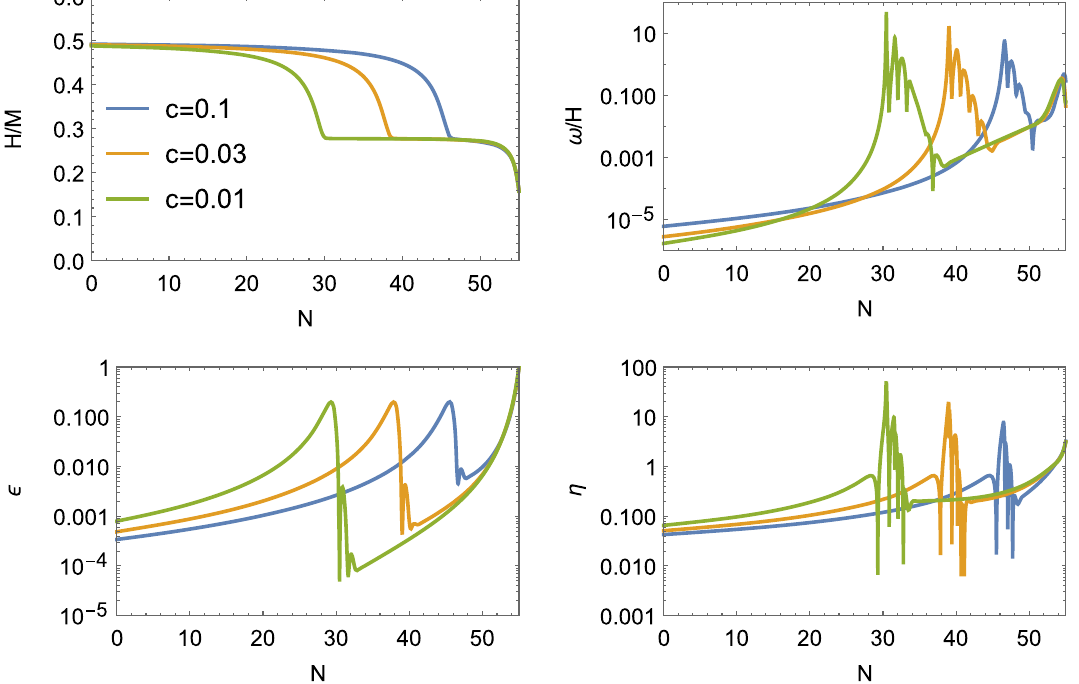
Fig. 7 The Hubble function H , the turn rate ω/ H , and the slow-roll parameters (cid:14),η during the last 55 e-folds for the parameter sets (45) in blue, orange, and green, respectively. The initial conditions for the